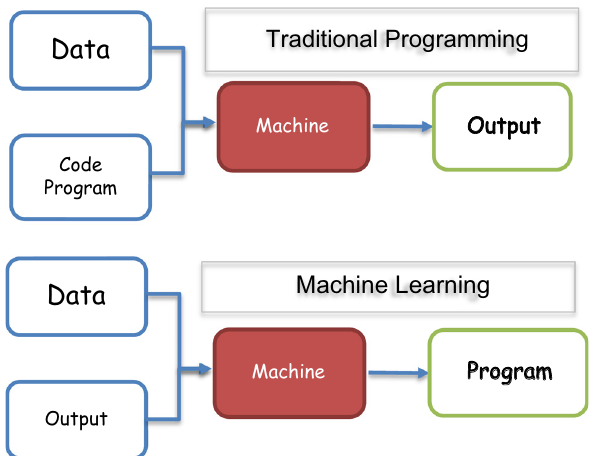
Figure 2: Flowchart of the principles of traditional programming methods ( above ) and ML programming ( below )